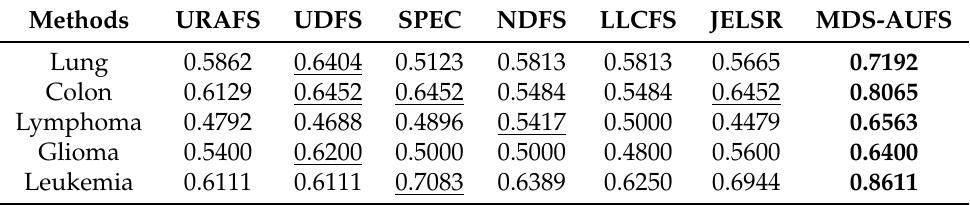
Table 3. Maximum clustering accuracy of different methods on five different datasets.